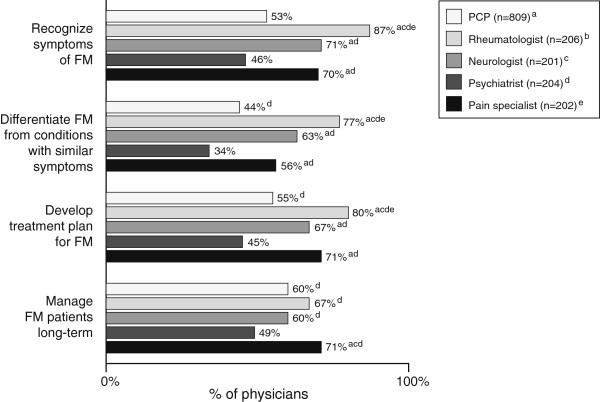
Physicians who reported being confident* in aspects of FM diagnosis and management. *Those who were very confident or confident. a, b, c, d, and e indicate statistically significant difference (P<0.05) among the subgroups (i.e., physician specialties) being analyzed.